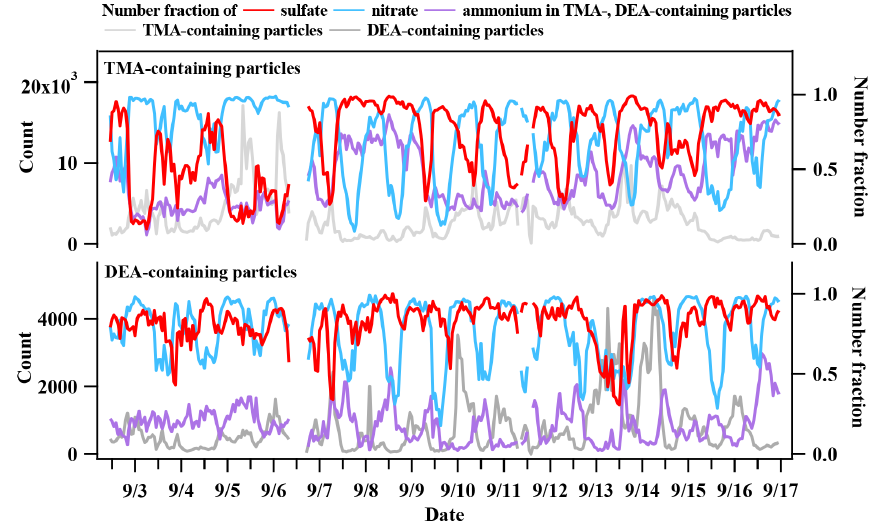
Figure 10. Temporal trends of TMA- and DEA-containing particle counts, and number fractions of nitrate, sulfate, and ammonium in TMA- and DEA-containing particles.